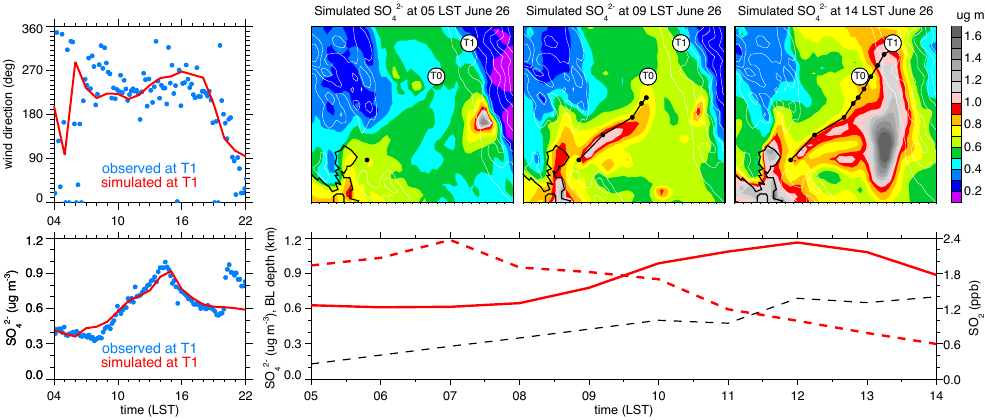
Figure 17. Observed and simulated time series of wind direction and SO 2 − Francisco Bay area and the T1 site at 05:00, 09:00, and 14:00LST and one air mass trajectory that arrives at the T1 site at 14:00LST during the peak afternoon SO 2 − concentration (upper right panels), and evolution of SO 2 − 4 trajectory (lower right